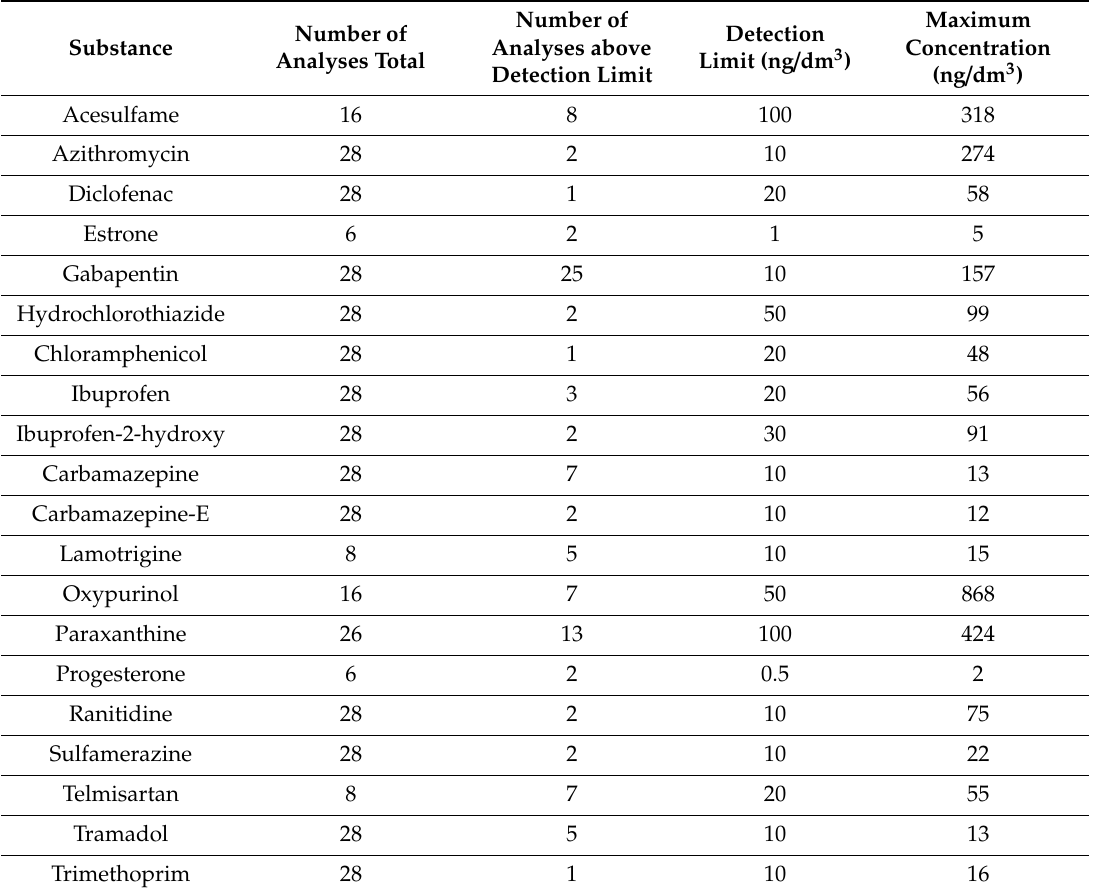
Table 11. Quality of raw water from the Svihov reservoir—all substances detected above the detection